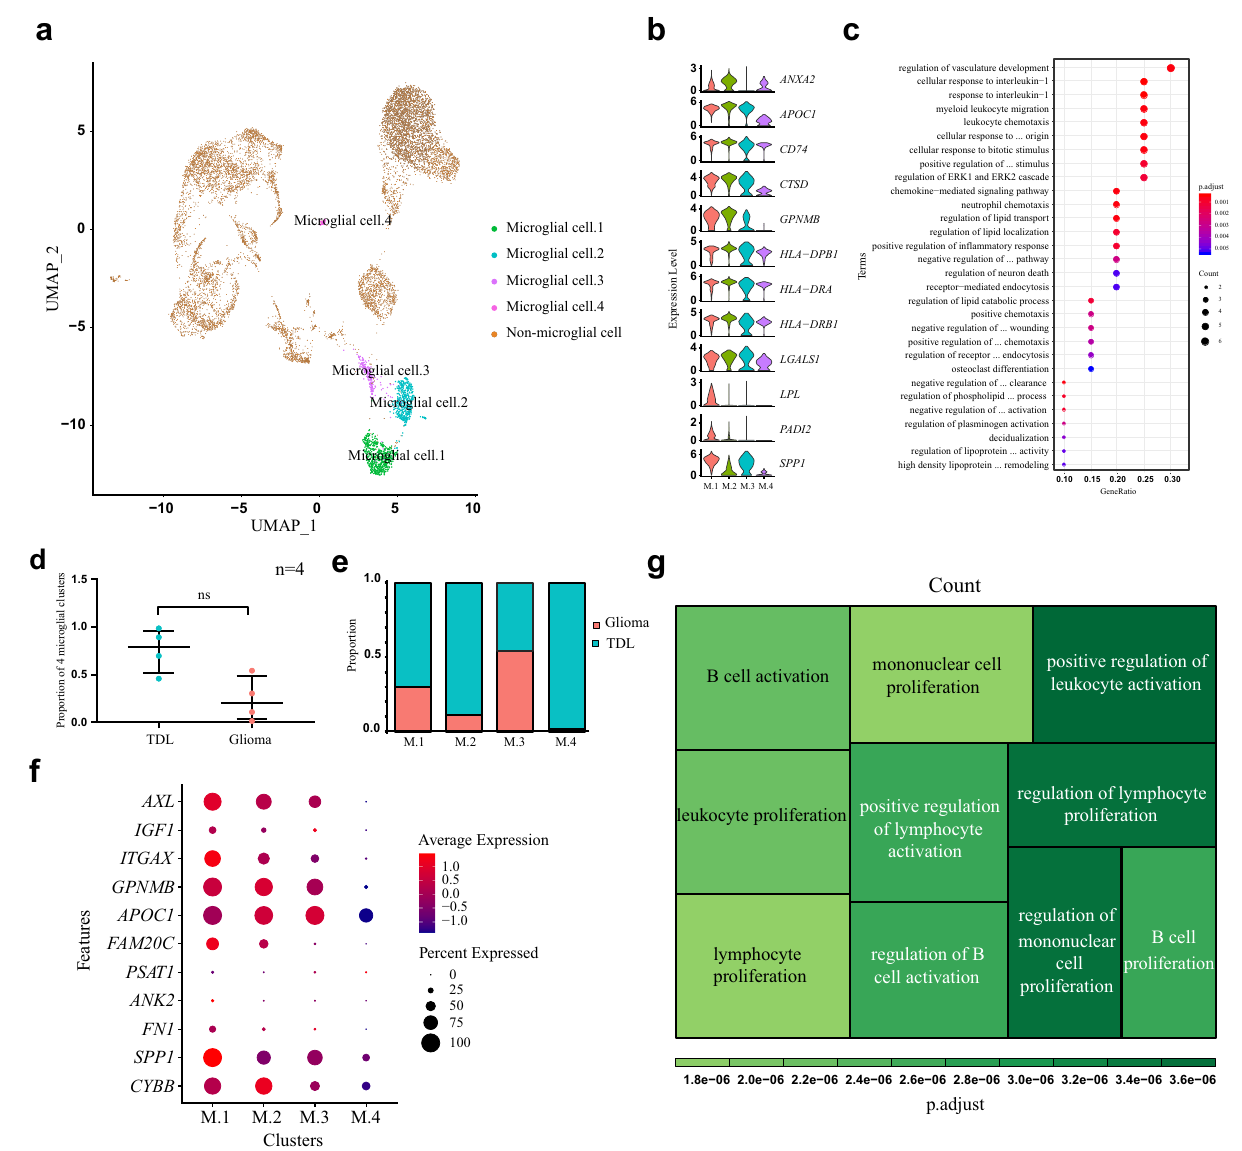
CYBBSPP1FN1ANK2PSAT1FAM20CAPOC1GPNMBITGAXIGF1AXL Fig. 2 Cell clusters of microglial cells and transcriptomic difference between TDL and glioma. a UMAP plot of microglial cells annotated into microglial cell.1 (M.1), microglial cell.2 (M.2), microglial cell.3 (M.3), microglial cell.4 (M.4). b Violin plot of human multiple sclerosis-related genes in four clusters. c Bubble plot of Gene Ontology (GO) enrichment analysis (BP biological process) based on top 20 markers in M.1. d Comparison of proportion of microglial cells in four clusters from TDL and glioma by nonparametric test (Mann – Whitney test). The data are expressed as median (interquartile range); n = 4 independent samples. A P -value < 0.05 was considered signi fi cant (ns, P > 0.05). e Proportion plot of microglial cells in four clusters deriving from TDL and glioma. f Dotplot of gene expression associated with demyelination and remyelination. g Treemap of Gene Ontology (GO) enrichment analysis for biological process based on top 20 markers in M.4. TDL tumefactive demyelinating lesion, UMAP Uniform Manifold Approximation and Projection, FC fold